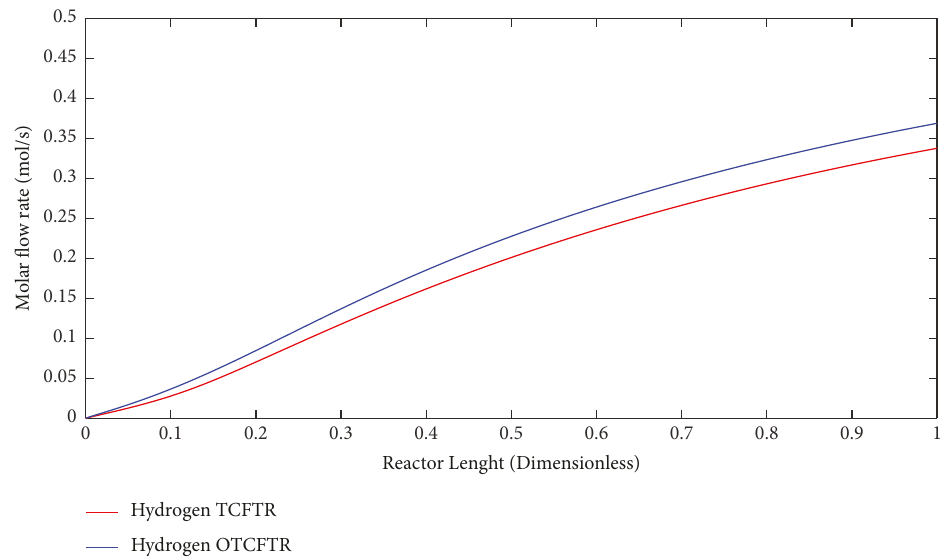
Figure 13: Comparison of the molar flow rate at the exothermic part for TCFTR and